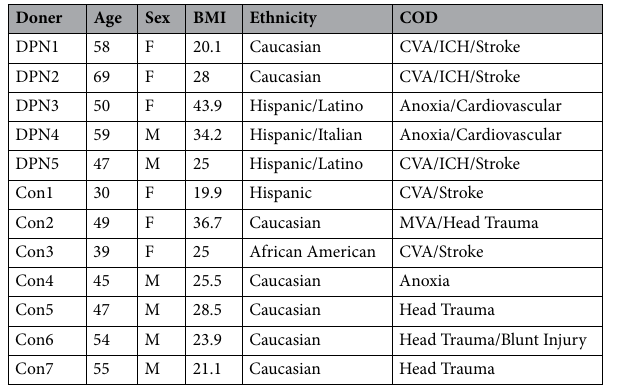
Table 1. Demographics on the DRG donors used in this study. BMI = Body Mass Index, COD = Cause of